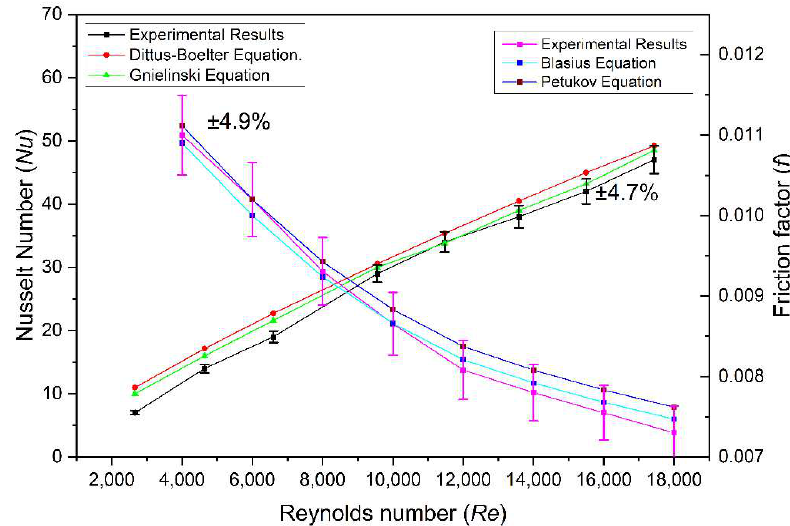
Figure 4. Experimental and predicted values for Nu and (cid:16)